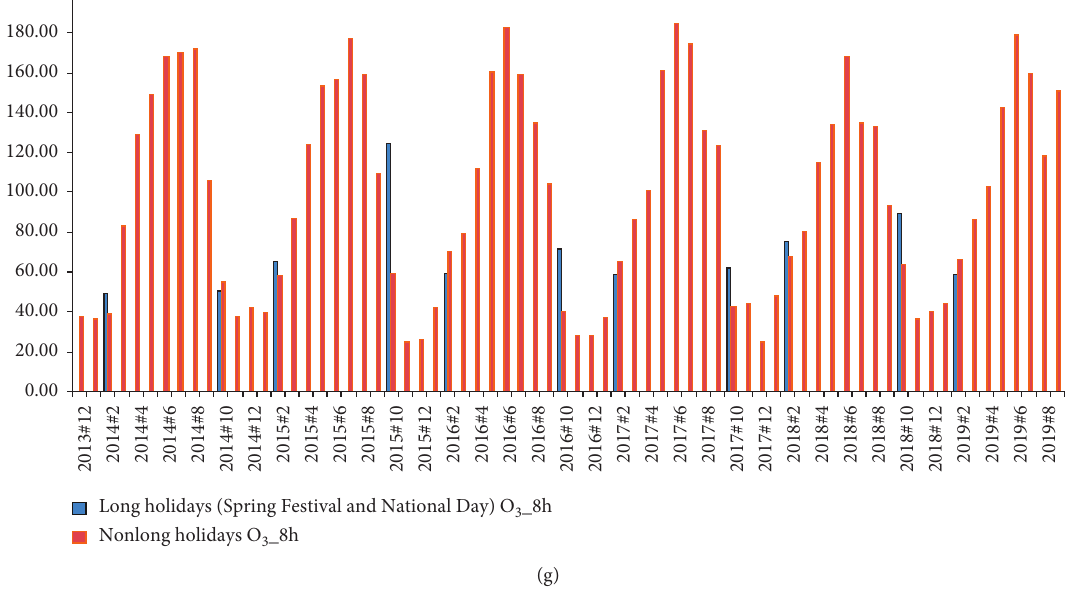
Figure 4: Comparison with long holidays and nonlong